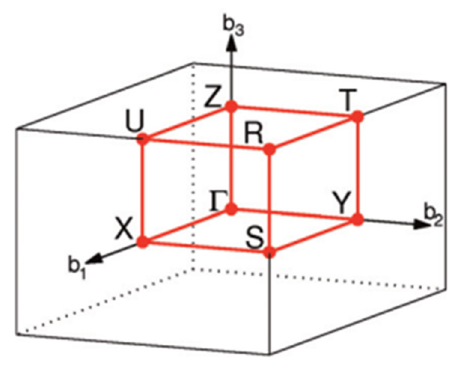
Figure 1. Brillouin zone sampling of orthorhombic lattice in the direction of Γ – X – S – Y – Γ – Z – U – R – T – Z ∣ Y – T ∣ U – X ∣ S – R.